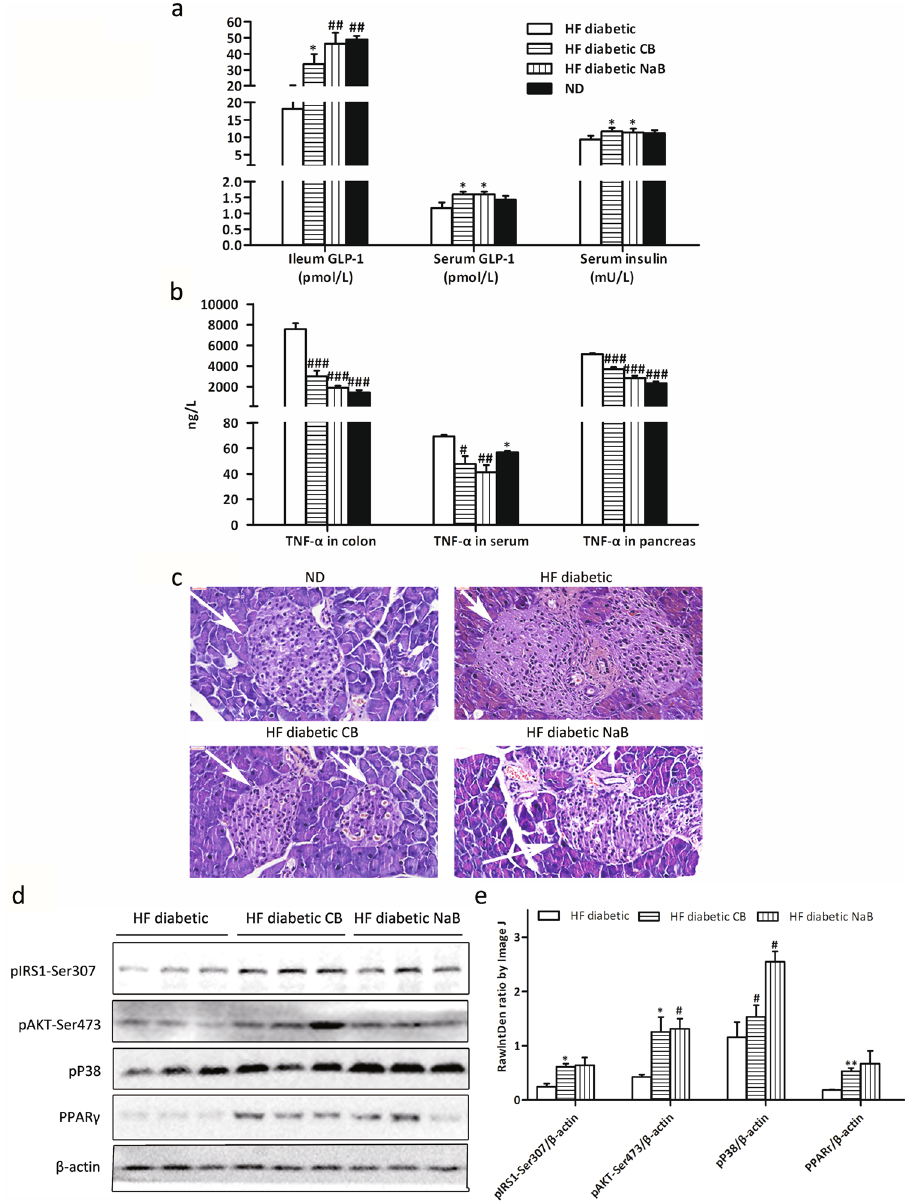
Figure 4. CB0313.1 alleviated pancreatic damage and enhanced insulin signaling in HF diabetic mice. ( a ) Ileum and serum GLP-1, and insulin; ( b ) Colon, serum and pancreas TNF- α ; ( c ) H&E staining of pancreas was performed to observe the morphology of islets; ( d ) Insulin signaling and PPAR γ in liver by Western blot; ( e ) Grey value analysis of western blot by Image J. Data are mean ± SEM (n = 3–12 mice per group). #, ##, ### p < 0.05, p < 0.01, p < 0.001 vs HF diabetic control by one-way ANOVA followed by the indicated post hoc test. * , ** , *** p < 0.05, p < 0.01, p < 0.001 vs HF diabetic control by t -test. HF diabetic: high fat diet and streptozotocin, HF diabetic CB: high fat diet and streptozotocin plus CB0313.1, HF diabetic NaB: high fat diet and streptozotocin plus NaB, ND: Normal